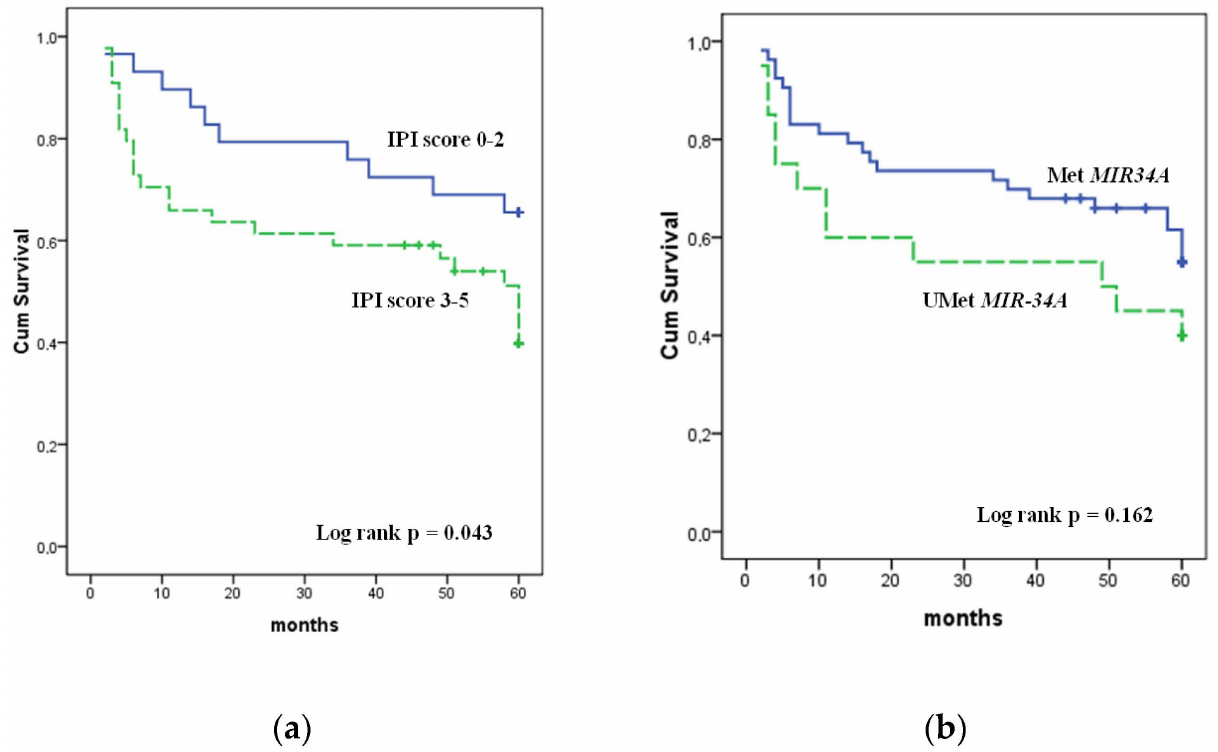
Figure 2. Overall survival of DLBCL patients: ( a ) IPI score 0–2 and 3–5; ( b ) with and without MIR-34A methylation